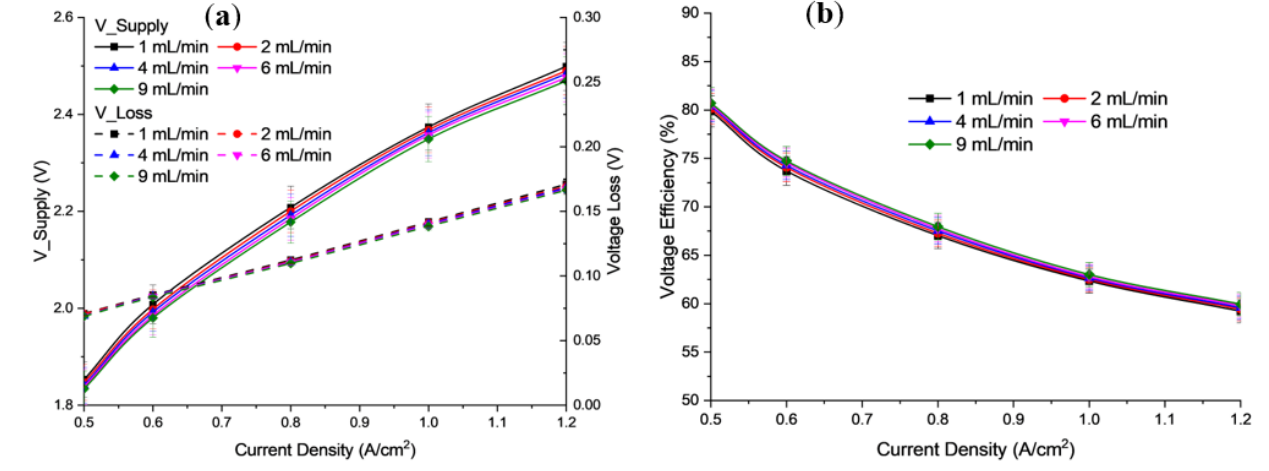
Figure 8. Profile of ( a ) Polarization curve, ( b ) Voltage efficiency for different electrolyte flow rate at 30 °C operational temperature and concentration of electrolyte 2.0 M